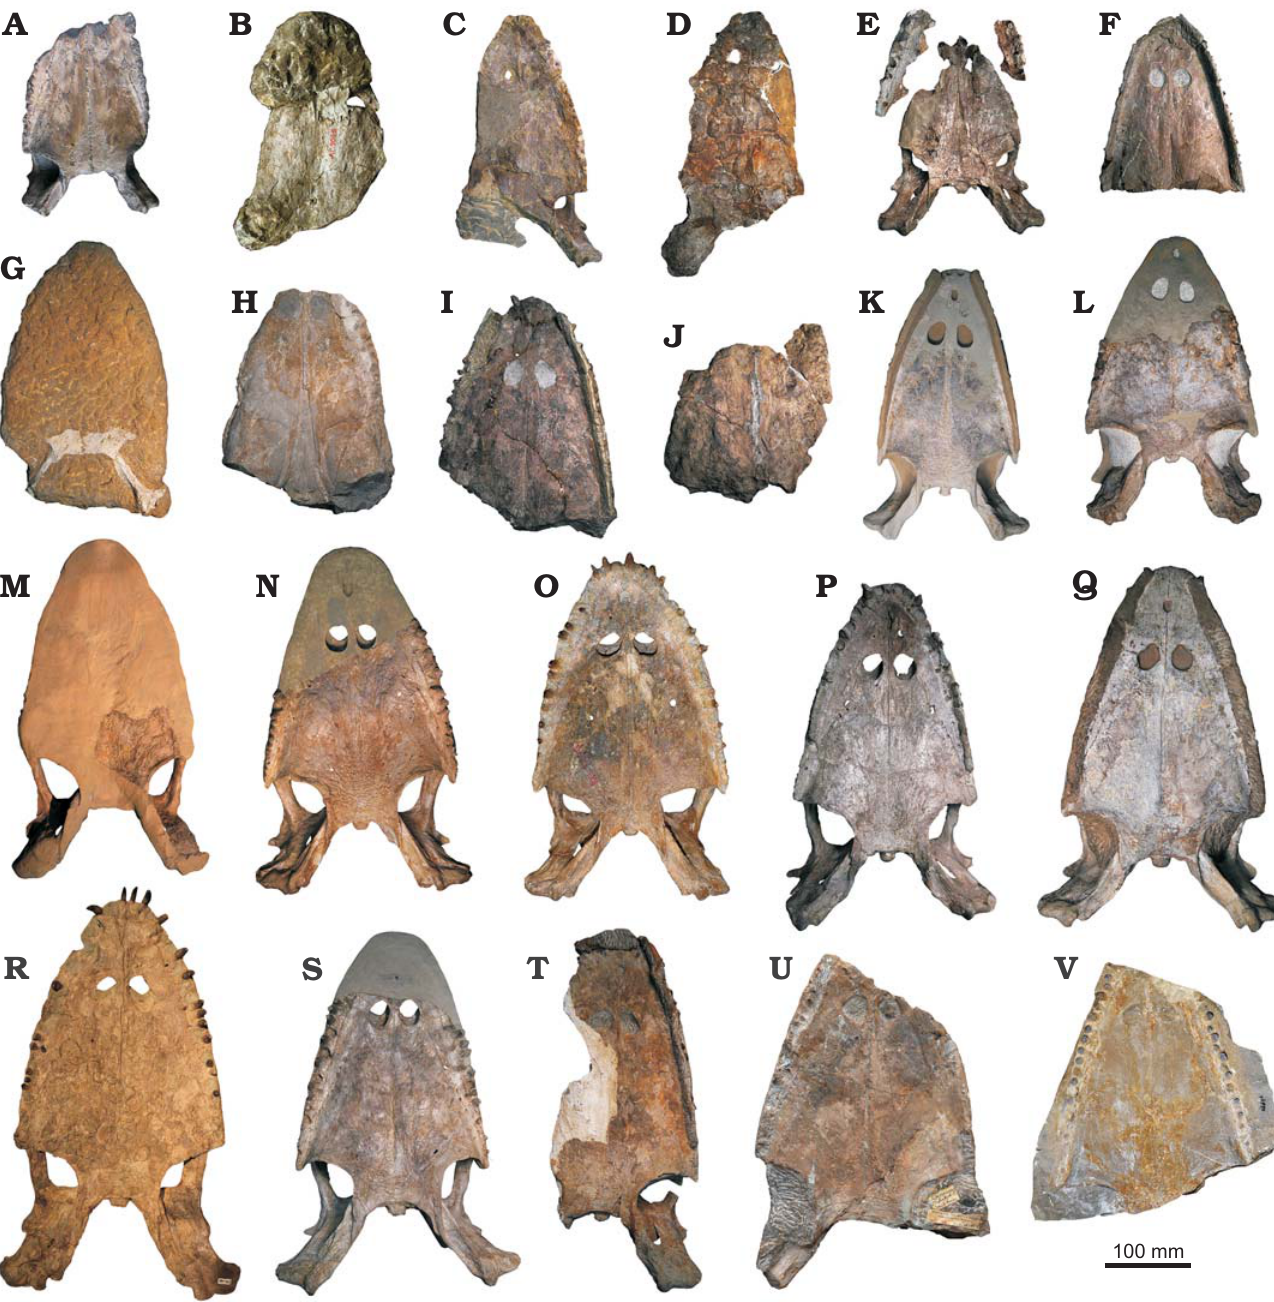
Fig. 3. Skulls of simosaurid sauropterygian Simosaurus gaillardoti Meyer, 1842 from the Ladinian, Middle Triassic of northeastern France (A, B) and southwestern Germany (C–V), in ventral view. A . MNHN.F.AC. 9026 (cast). B . MNHN.F.AC. 9025. C . SMNS 18274. D . SMNS 16639. E . SMNS 16767. F . SMNS 18520. G . SMNS 16700 (holotype of “ Simosaurus guilielmi ” Meyer, 1852). H . SMNS 11364. I . SMNS 18550. J . SMNS 16735a. K . SMNS 56288. L . SMNS 59366. M . MHI 1366. N . SMNS 50714. O . GPIT/RE/09313. P . SMNS 10360. Q . SMNS 16363. R . MHI 1833. S . SMNS